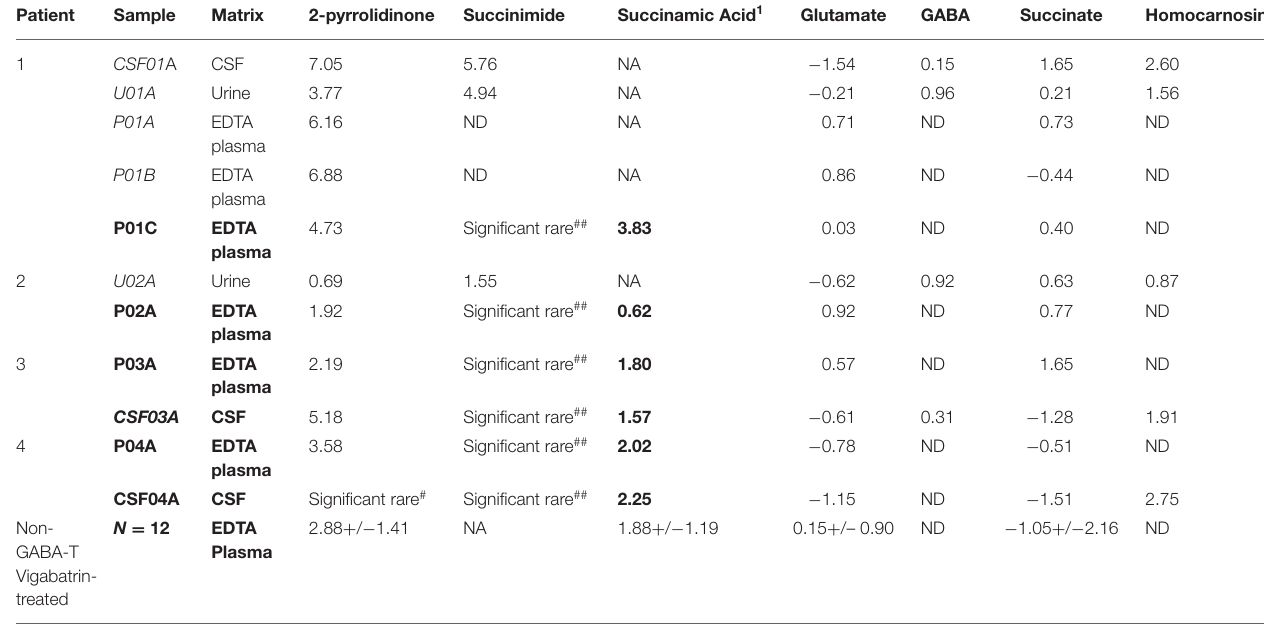
TABLE 2 | Metabolomics identifies altered levels of molecules connected to GABA metabolism in GABA-transaminase deficiency patients*. Patient